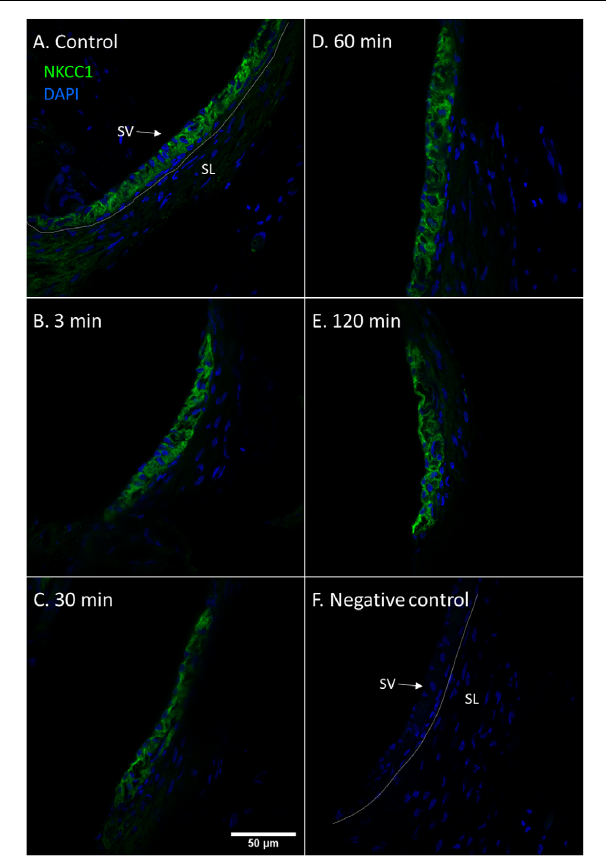
FIGURE 2 | NKCC1 in the stria vascularis following furosemide injection. (A–F) Staining intensity of NKCC1 in the marginal cells of the stria vascularis following furosemide injection with DAPI staining of nuclei. Focus was set on the stria vascularis. Spiral ligament (SL); Stria vascularis (SV). (A) Normal NKCC1 staining in the stria vascularis in a control animal. (B) Intensity had decreased after 3 min. (C) The lowest intensity was seen at 30 min. (D) It then recovers partially at 60 min. (E) Further recovery at 120 min. (F) Negative control with